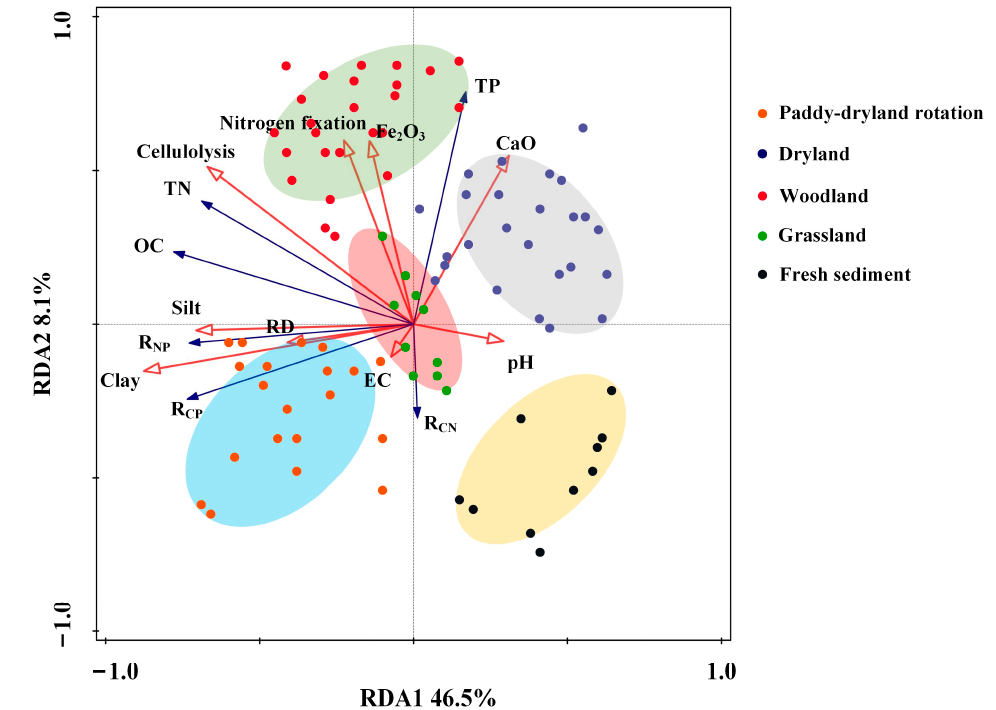
Figure 6. Redundancy analysis (RDA) of soil nutrients stoichiometry with environmental variables. The signi fi cance of the RDA analysis results was tested by a Monte Carlo permutation test. OC, organic carbon; TN, total nitrogen; TP, total phosphorus; EC, electrical conductivity; RD, reclama- tion